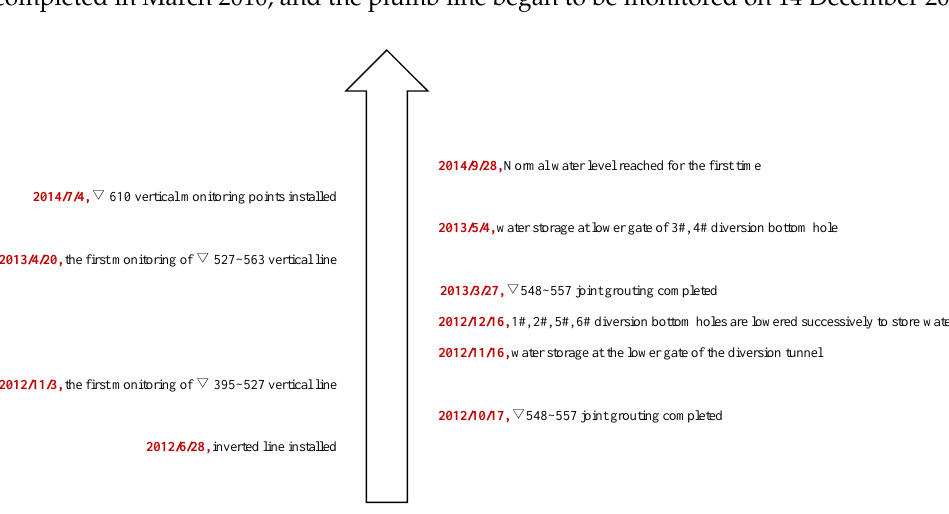
Figure 5. Comparison of monitoring and construction progress of Xiluodu arch dam.